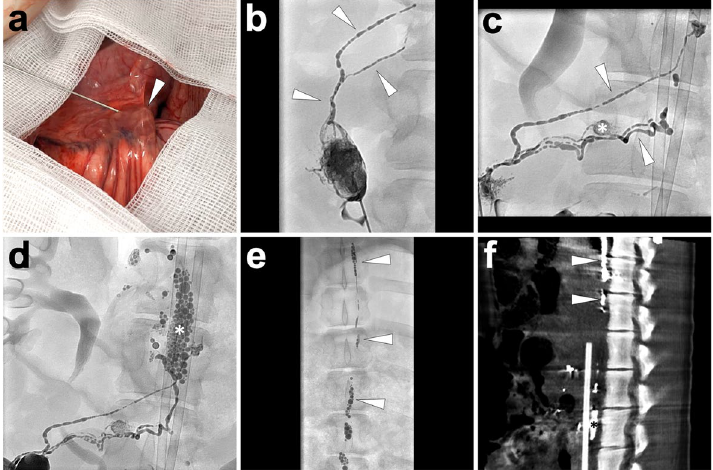
Fig. 5 Illustration of lipiodol-based laparoscopic INL in a pig model. After laparotomic exposure of the mesentery, the translucent lymph node ( white arrowhead ) was punctured using a 22-gauge Chiba needle ( A ). Under fluoroscopy monitoring, a small amount of lipiodol (1 ml) was first injected. The opacification of the targeted lymph node and efferent lymphatic vessels ( white arrowheads ) indicated an ideal needle position ( B ). Afterwards, continuous injection of lipiodol visualized the mesenteric lymphatics ( white arrowheads ; C ), mesenteric lymph nodes ( * ; C ), cisterna chyli ( * ; D ), and thoracic duct ( white arrowheads ; E ). The MIP image of the following post-lymphangiography CT presented the details between lymphatic structures such as cisterna chyli ( * ) and thoracic duct ( white arrowheads ) to the surrounding tissue ( F ). Images were from Pig No. 4 . Abbreviations: INL, intranodal lymphangiography; MIP, maximum intensity projection; CT, computed